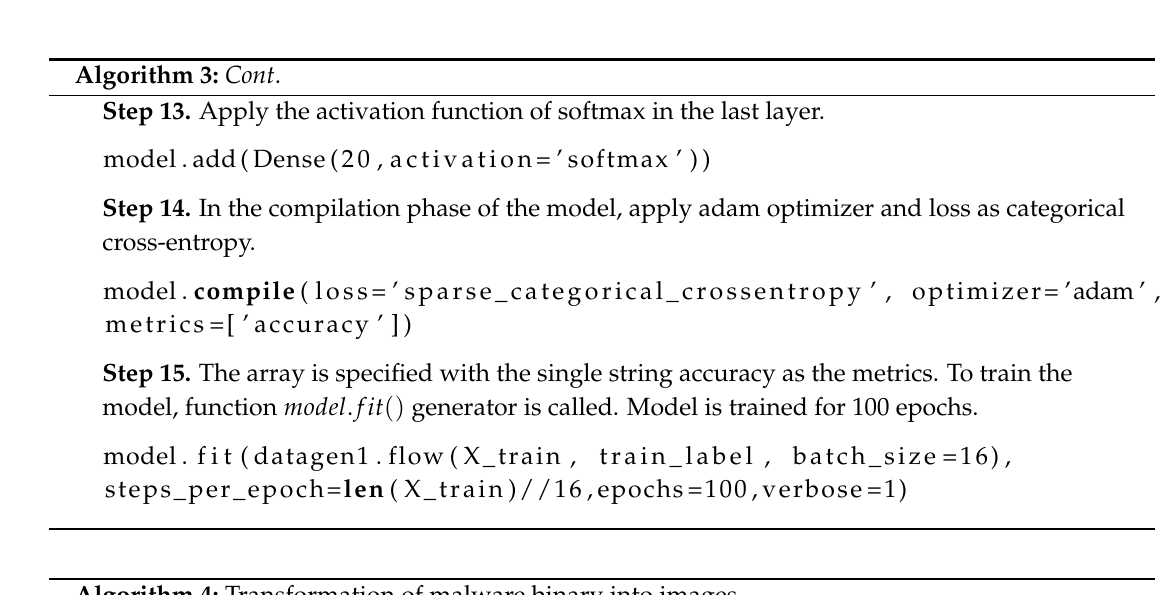
Algorithm 4: Transformation of malware binary into